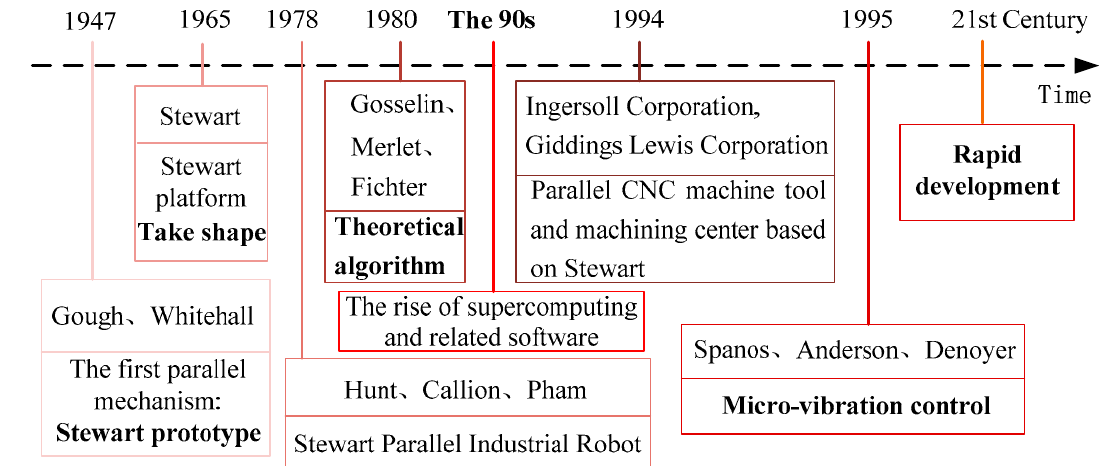
Figure 8. Development history of the Stewart Platform [31,49–52].